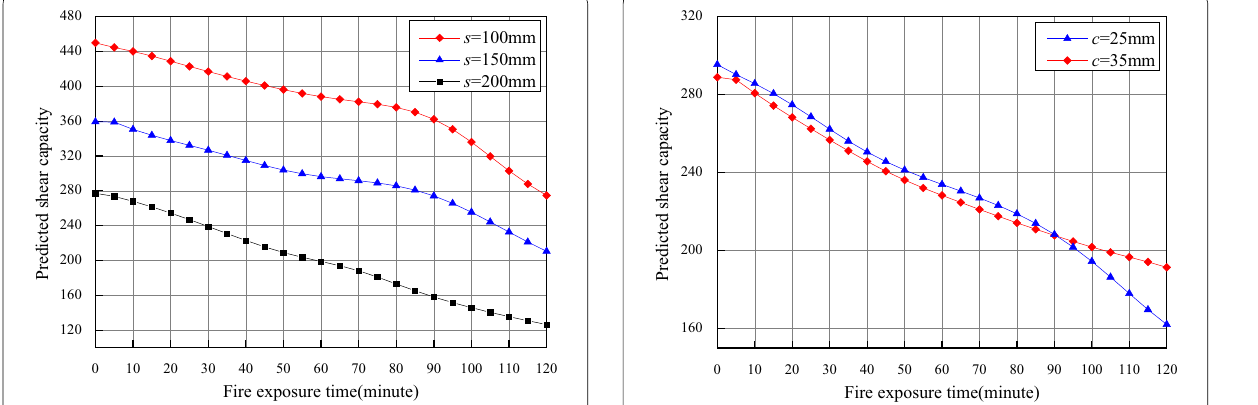
Fig. 13 Effect of concrete cover thickness c on shear resistance of